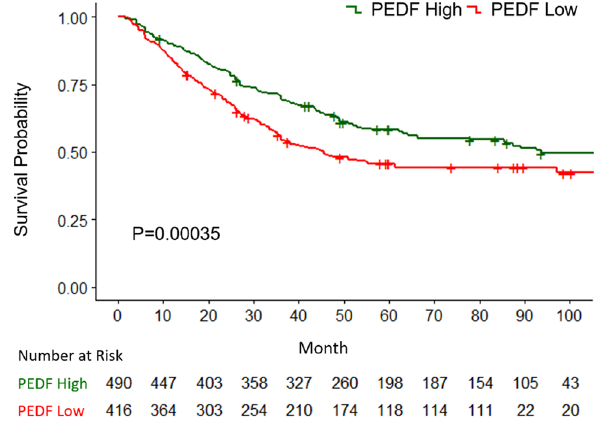
Fig. 6 Cancer patients with high-PEDF protein expression have longer overall survival shown in Kaplan–Meier curves. Green line represents the OS of patients with high PEDF-expressing cancers whereas red line represents the OS of patients with low PEDF-expressing